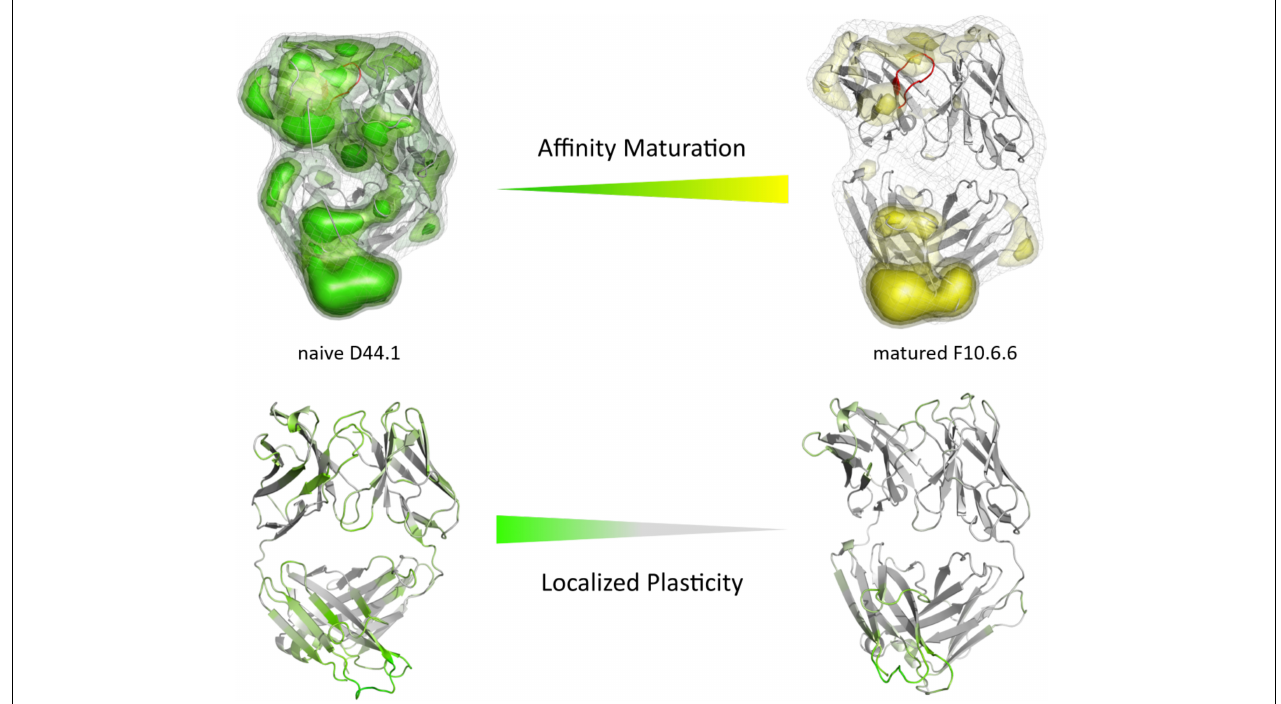
FIGURE 3 | Global (top) and localized (bottom) surface plasticity of the naive D44.1 and matured F10.6.6 antibody Fab mapped onto a representative ensemble structure. (Top) Global plasticity of the naïve and the matured D44.1 and F10.6.6 antibody fragments, highlighting the CDR-H3 loop in red. The intensity of the colors reflects the regions with higher plasticity and thus allows localization. (Bottom) Localized plasticity for both the naïve and the matured D44.1 and F10.6.6 antibody fragment Fab,